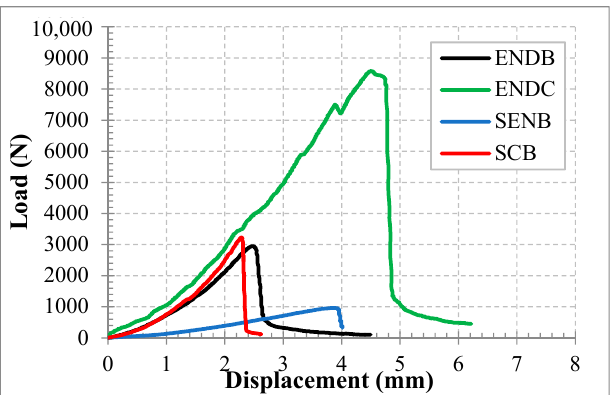
Figure 7. Fracture trajectory and fracture surfaces observed for the tested ENDB, SCB, SENB and ENDC specimens.